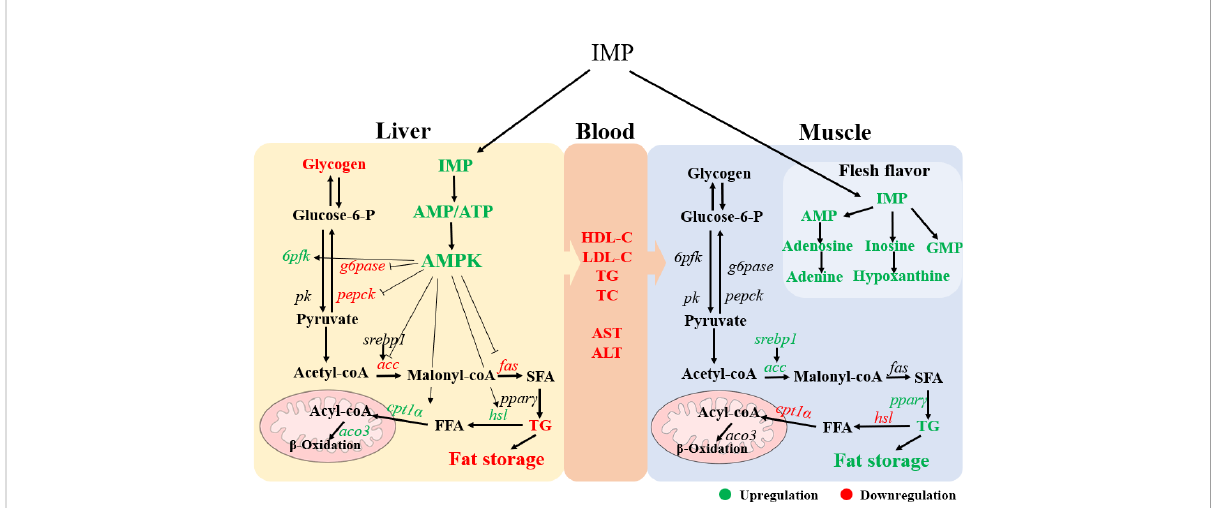
FIGURE 6 The schematic diagram showing a proposed mechanism for exogenous IMP on physiological metabolism of gibel carp. IMP increased the ration of AMP/ATP in liver, which activated AMPK signal pathway. This activation reduced the content of fat and glycogen in liver by regulating fat and glucose metabolism. In addition, increased fat deposition and the fl avor substance inosinic acid in the muscle. Green color indicates upregulation and red color indicates